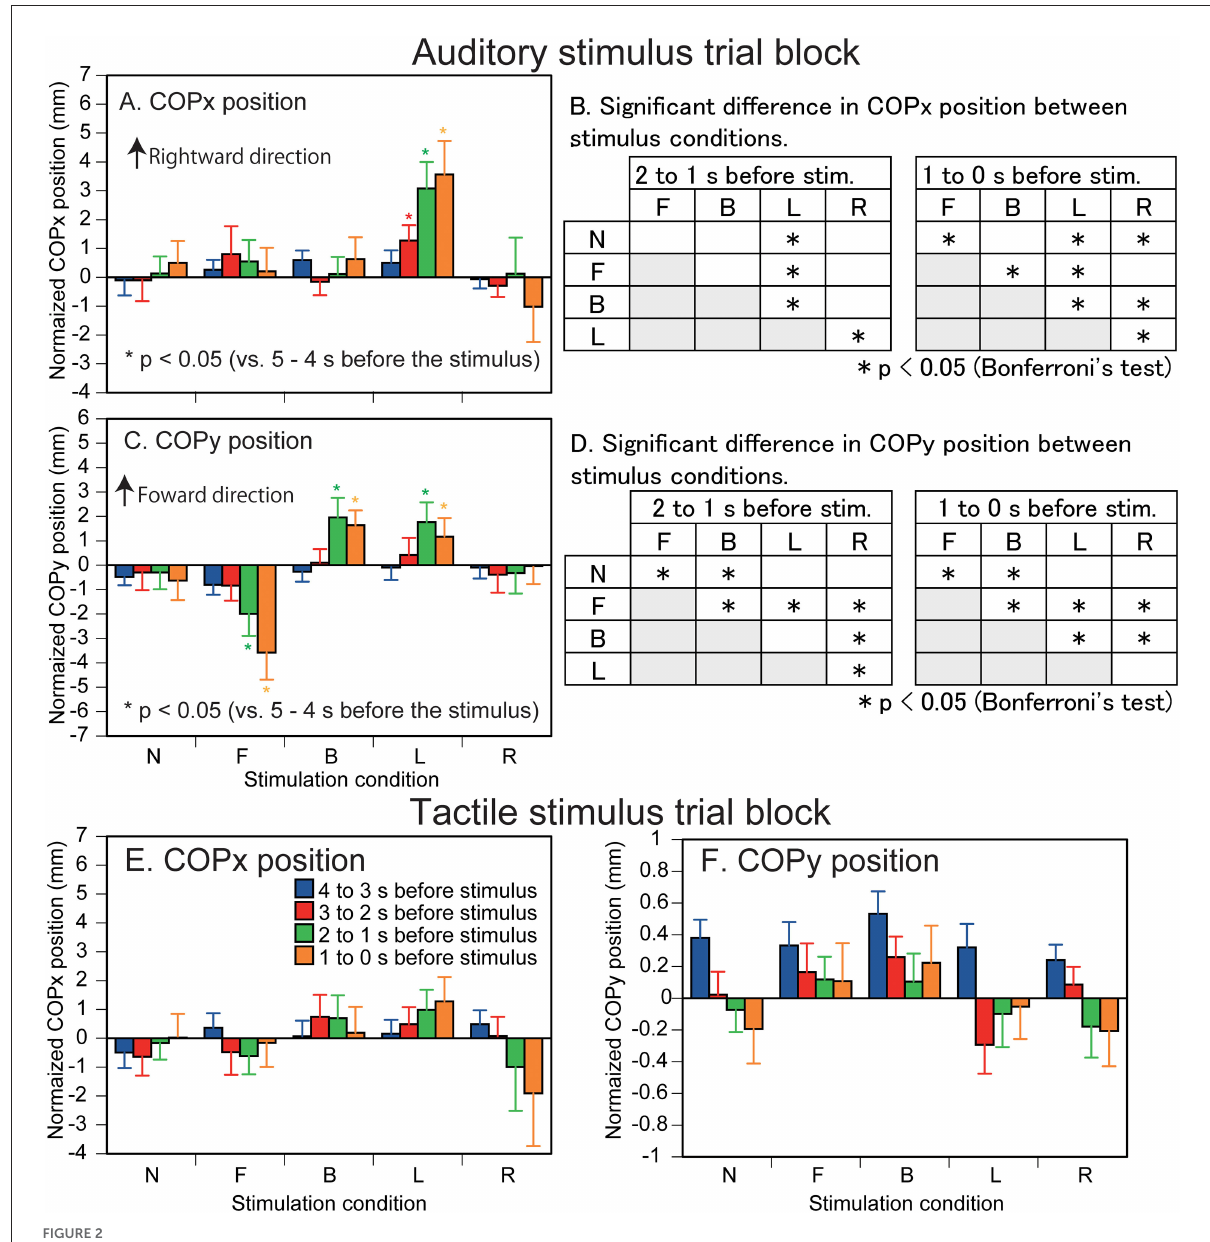
FIGURE2 Effect of predicting the auditory (A–D) and tactile stimulus site (E,F) on the COP position. Bars indicate the mean, and error bars indicate standard errors of the mean (A,C,E,F) . The data are normalized by subtracting the average value at 1–0s before the onset of the visual cue (5–4s before the stimulus) from the values averaged at every 1s in the time window between 4 and 0s before the stimulus. Asterisks indicate significant differences in the COP position compared with the COP position at the time 5–4s before the stimulus (1–0s before the visual cue) in the same condition. Results of Bonferroni’s test examining the difference between the stimulus conditions are shown in B and D . N, trials with the cue predicting non-stimulation; F, trials with the cue predicting the stimulus to the forehead; B, trials with the cue predicting the stimulus to the back of the head; L, trials with the cue predicting the stimulus to the left side of the head; R, trials with the cue predicting the stimulus to the right side of the head.